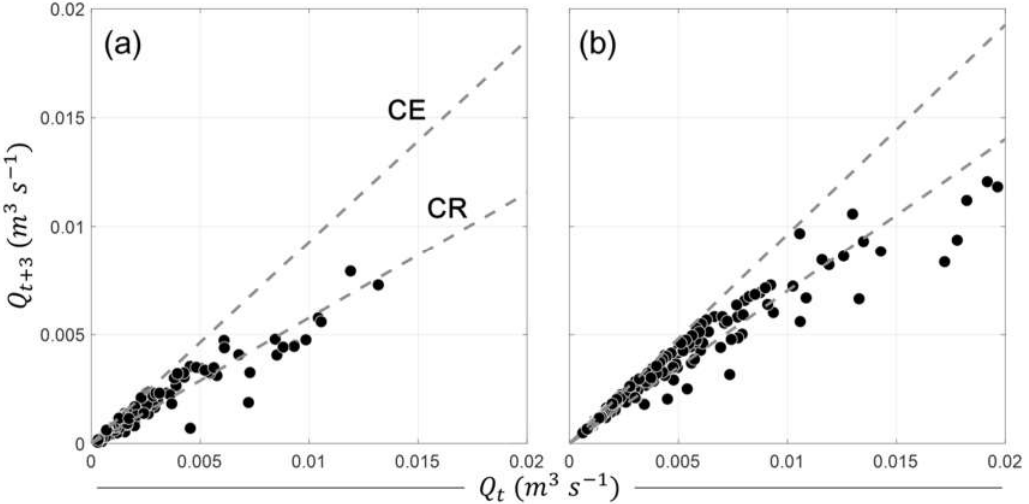
Figure 4. Recession constants obtained with the correlation method at the ( a ) GC and ( b ) GD catchments. The higher gradient line is the correlation enveloped line (CE) and the lower gradient line is the correlation regression line